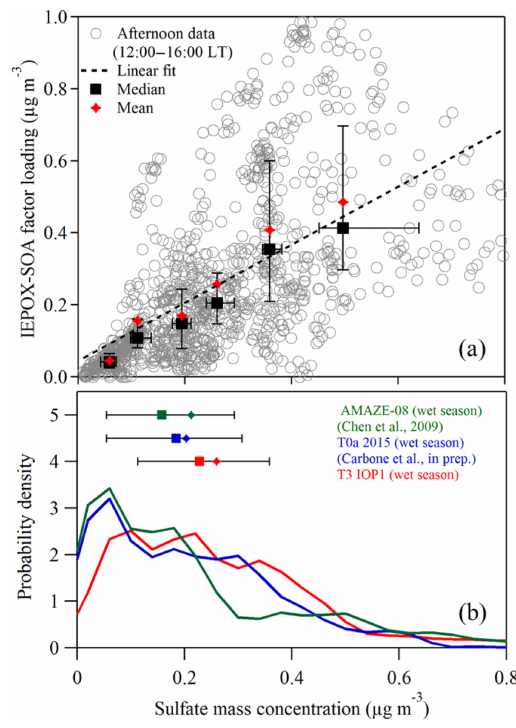
Figure 5. (a) Scatter plot of sulfate mass concentration and IEPOX- SOA factor loading. A least-squares linear fit is represented by the dashed line ( R 2 = 0 . 37). The data set was collected into six subsets based on sulfate concentration to calculate statistics. Me- dians (squares) and means (diamonds) of each subset are plot- ted. Whiskers on the medians represent the interquartile ranges. (b) Probability density function of sulfate mass concentration at the background site T0t (TT34) north of Manaus in the wet season of 2008 (Chen et al., 2009; Martin et al., 2010b, 2016b), at the back- ground site T0a (ATTO) northeast of Manaus in the wet season of 2015 (Andreae et al., 2015), and at T3 during the wet season of 2014 (IOP1). The plotted data sets were recorded during local af- ternoons (12:00–16:00 local time; 16:00–20:00UTC). Means (dia- monds), medians (squares), and interquartile range (whiskers) are shown for the probability density